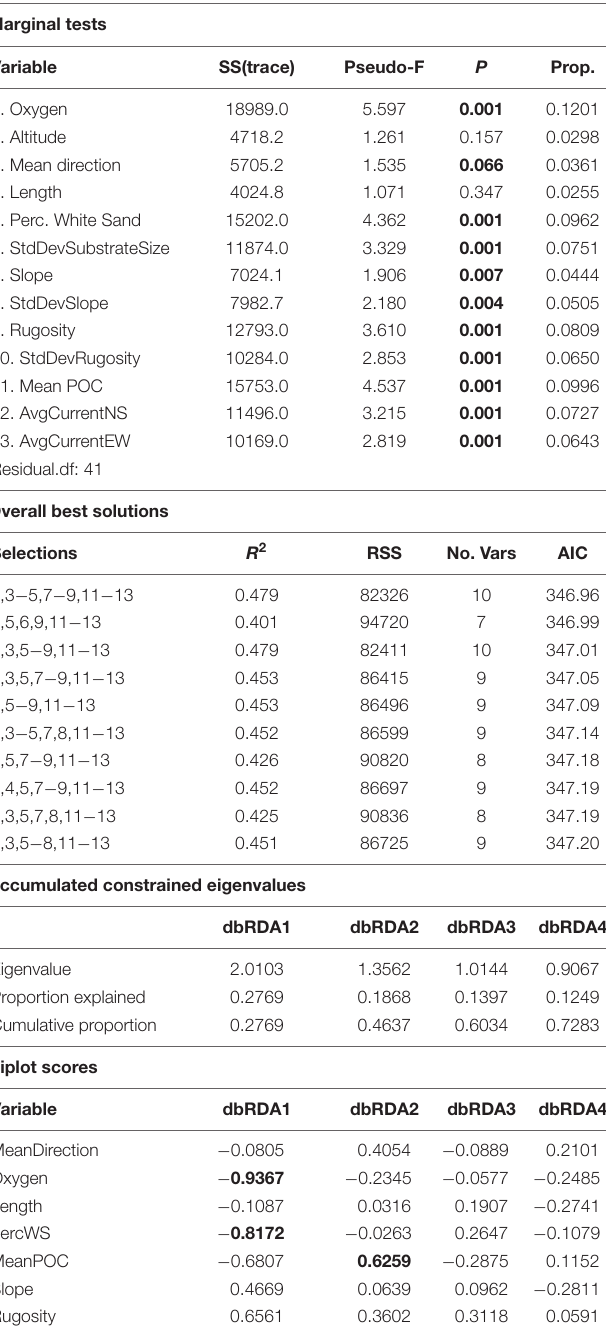
TABLE 2 | Results from DISTLM model and dbRDA analysis for Mokumanamana